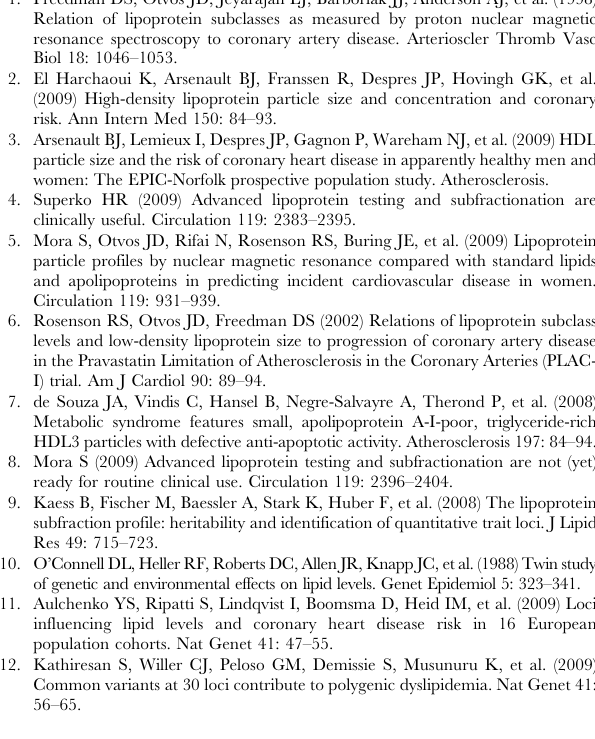
Table S4 Replication analyses in WGHS and PROCARDIS. SGCD SNPs in WGHS were not imputable due to low minor allele frequency. Beta-coefficients are given per copy of minor allele, assuming an additive model of inheritance, adjusted for age (and gender in PROCARDIS). rsq: imputation quality measure; MAF: minor allele frequency * Due to low MAF, homozygous and heterozygous carriers of the minor allele were pooled, hence the beta-coefficient is given for the presence of the minor allele. Found at: doi:10.1371/journal.pone.0014529.s007 (0.03